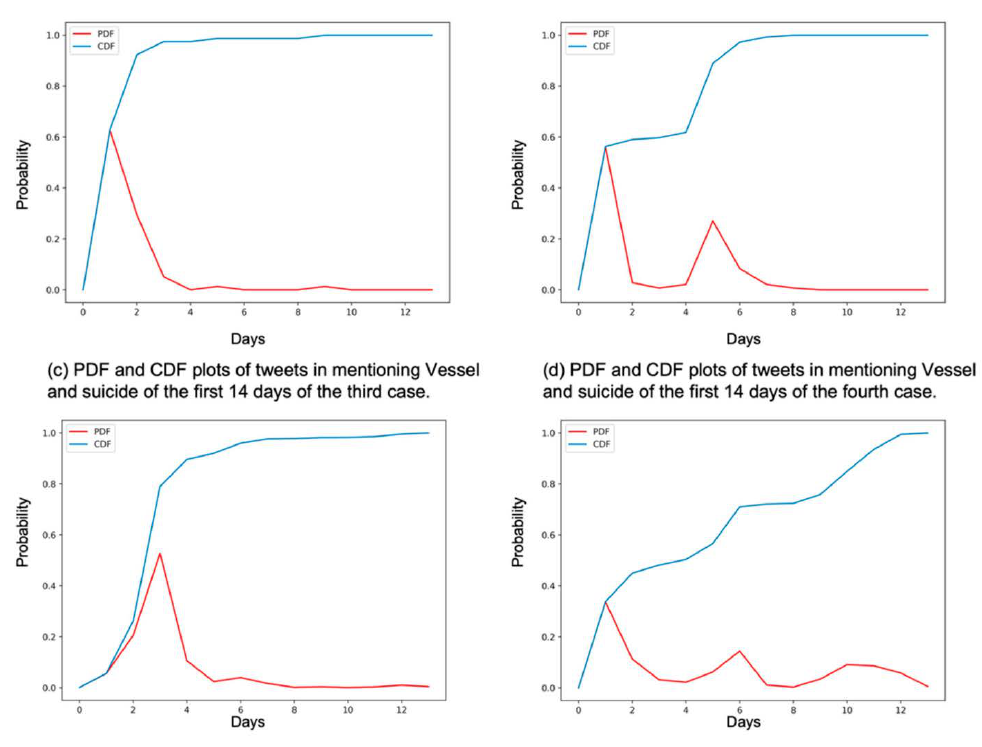
Figure 5. ( a – d ) are the probability density function (PDF-red) and cumulative distribution function (CDF-blue) plots of tweets mentioning Vessel and suicide within the first 14 days of the first, second, third, and fourth suicide cases,